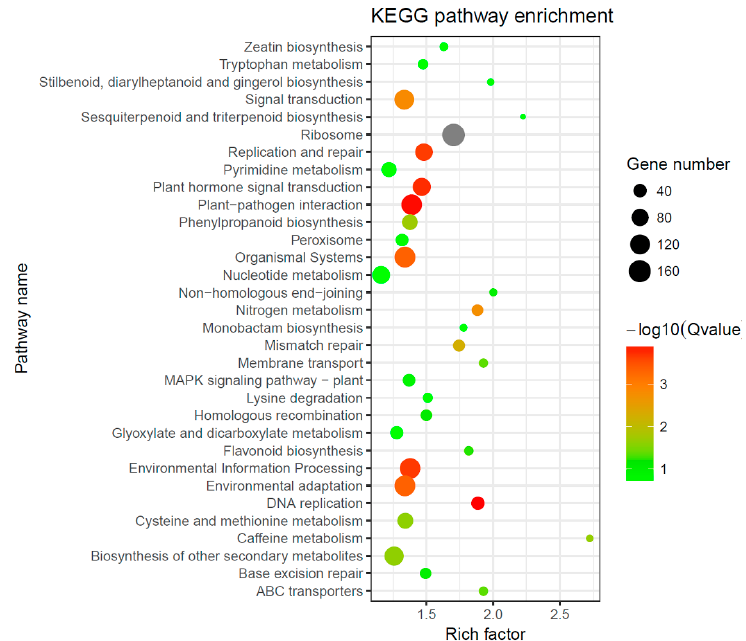
Figure 6. KEGG enrichment analysis of DEGs.